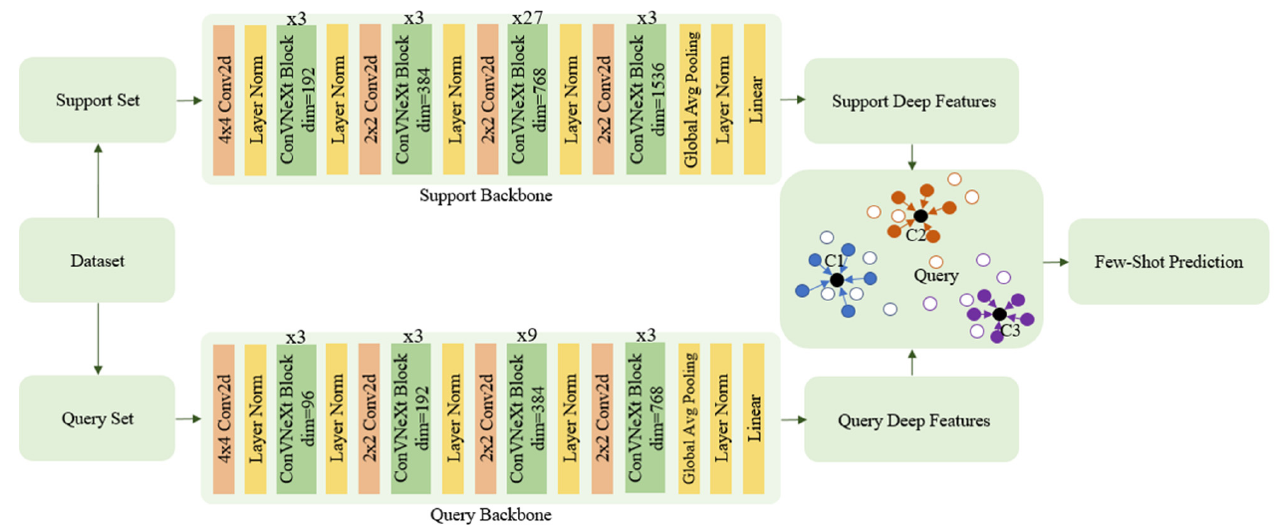
Figure 6. Few-shot classification with dual-model deep feature extraction and similarity measurement mechanism.